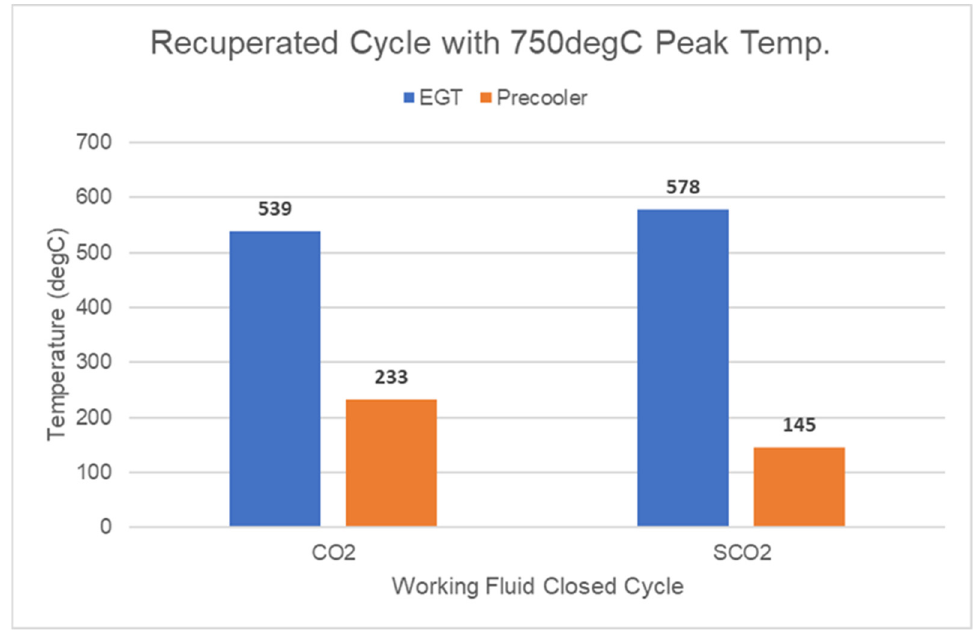
Figure 9. Turbine-exhaust-gas temperature (EGT) and precooler temperature for a core-outlet tem- perature (COT) of 950 °C.